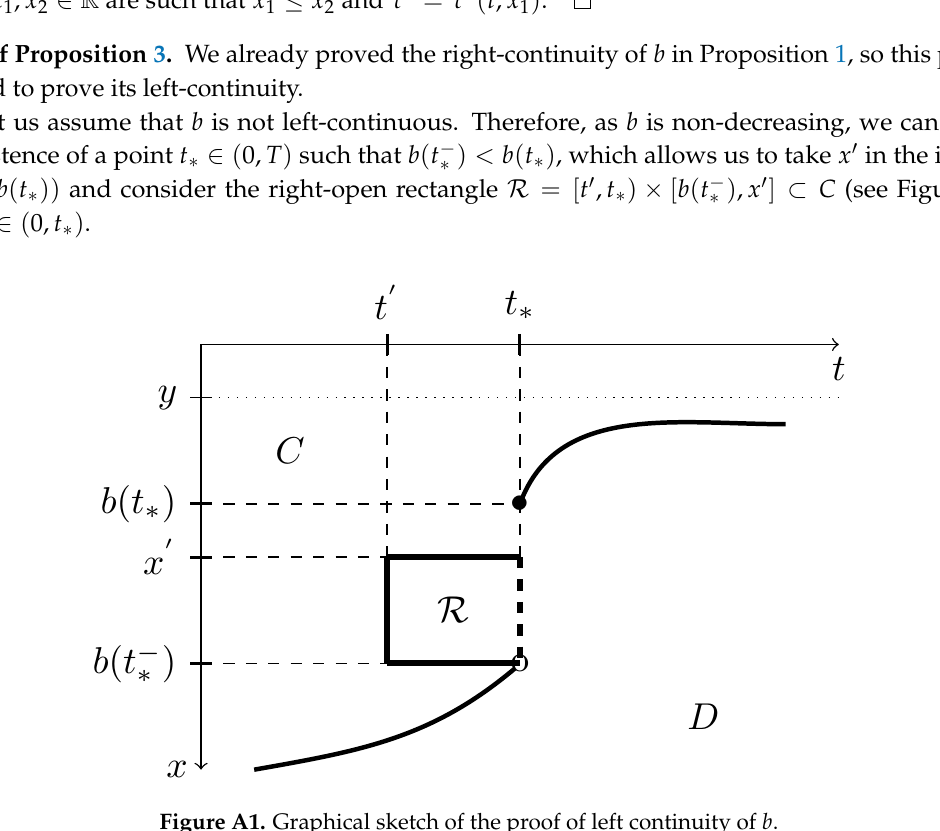
Figure A1. Graphical sketch of the proof of left continuity of b